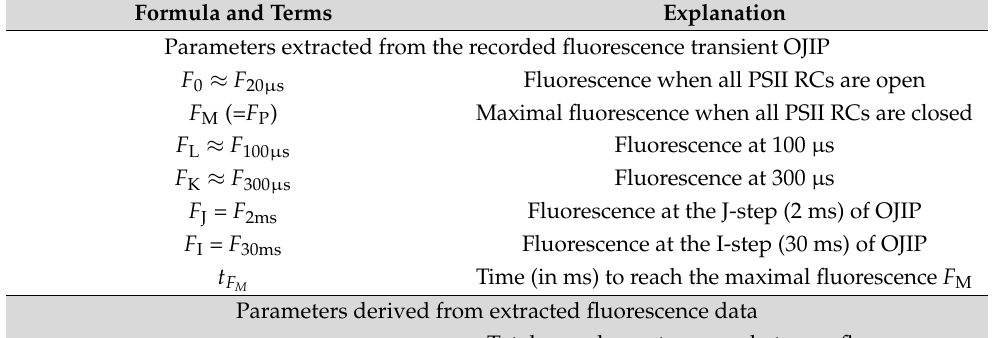
Table 1. Glossary, formula, and explanation of terms used in the JIP-test for analysis OJIP fluorescence transient curve emitted by dark-adapted photosynthetic samples in this study. Subscript “0” (or “o”) indicates that the parameter refers to the onset of illumination. Symbol “ F ” stands for “fluorescence”, meaning fluorescence